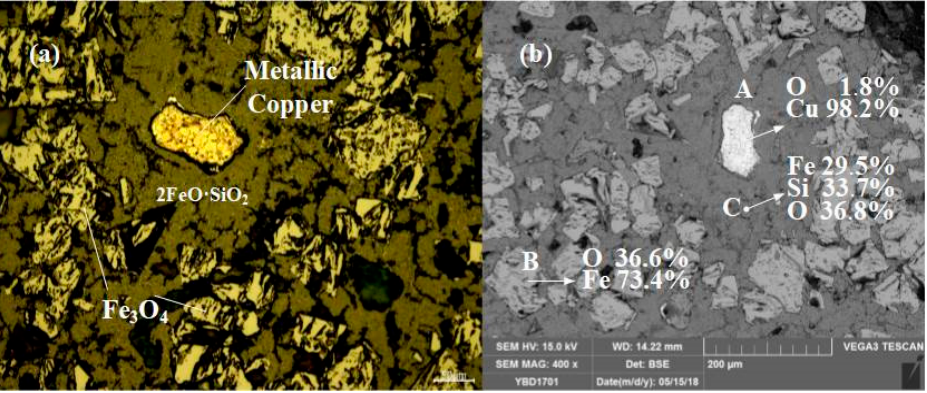
Figure 23. Optical micrograph ( a ) and SEM backscattered electron image ( b ) of YBD17. Sample YBD18: Under the metallographic microscope, a conglomerate of sponge copper debris could be detected, with Cu 2 O solid solution present. EDS characterization